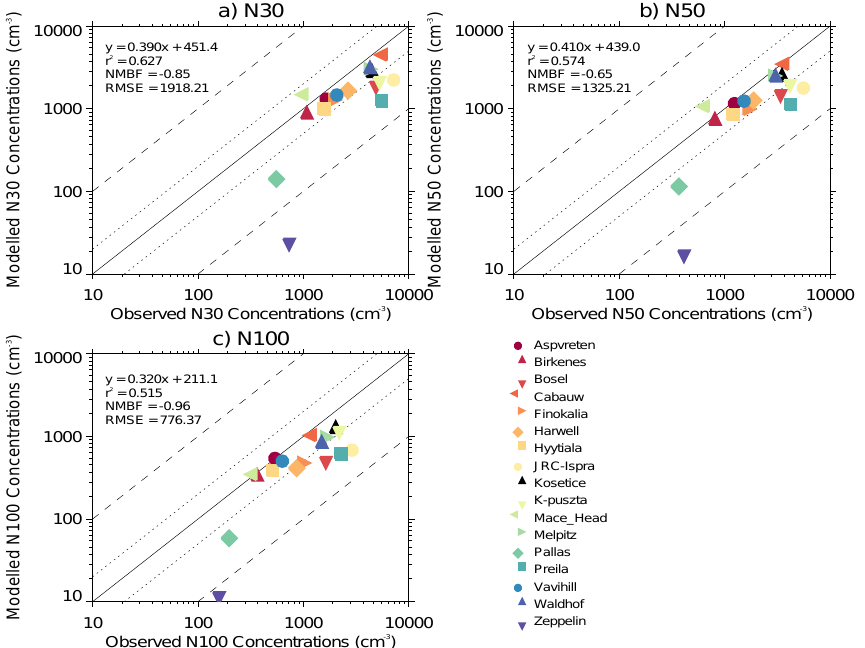
Figure 11. Annual mean observed vs. simulated aerosol number concentrations for (a) N30 (particles greater than 30nm diameter), (b) N50 ( > 50nm) and (c) N100 ( > 100nm) at monitoring sites across Europe.